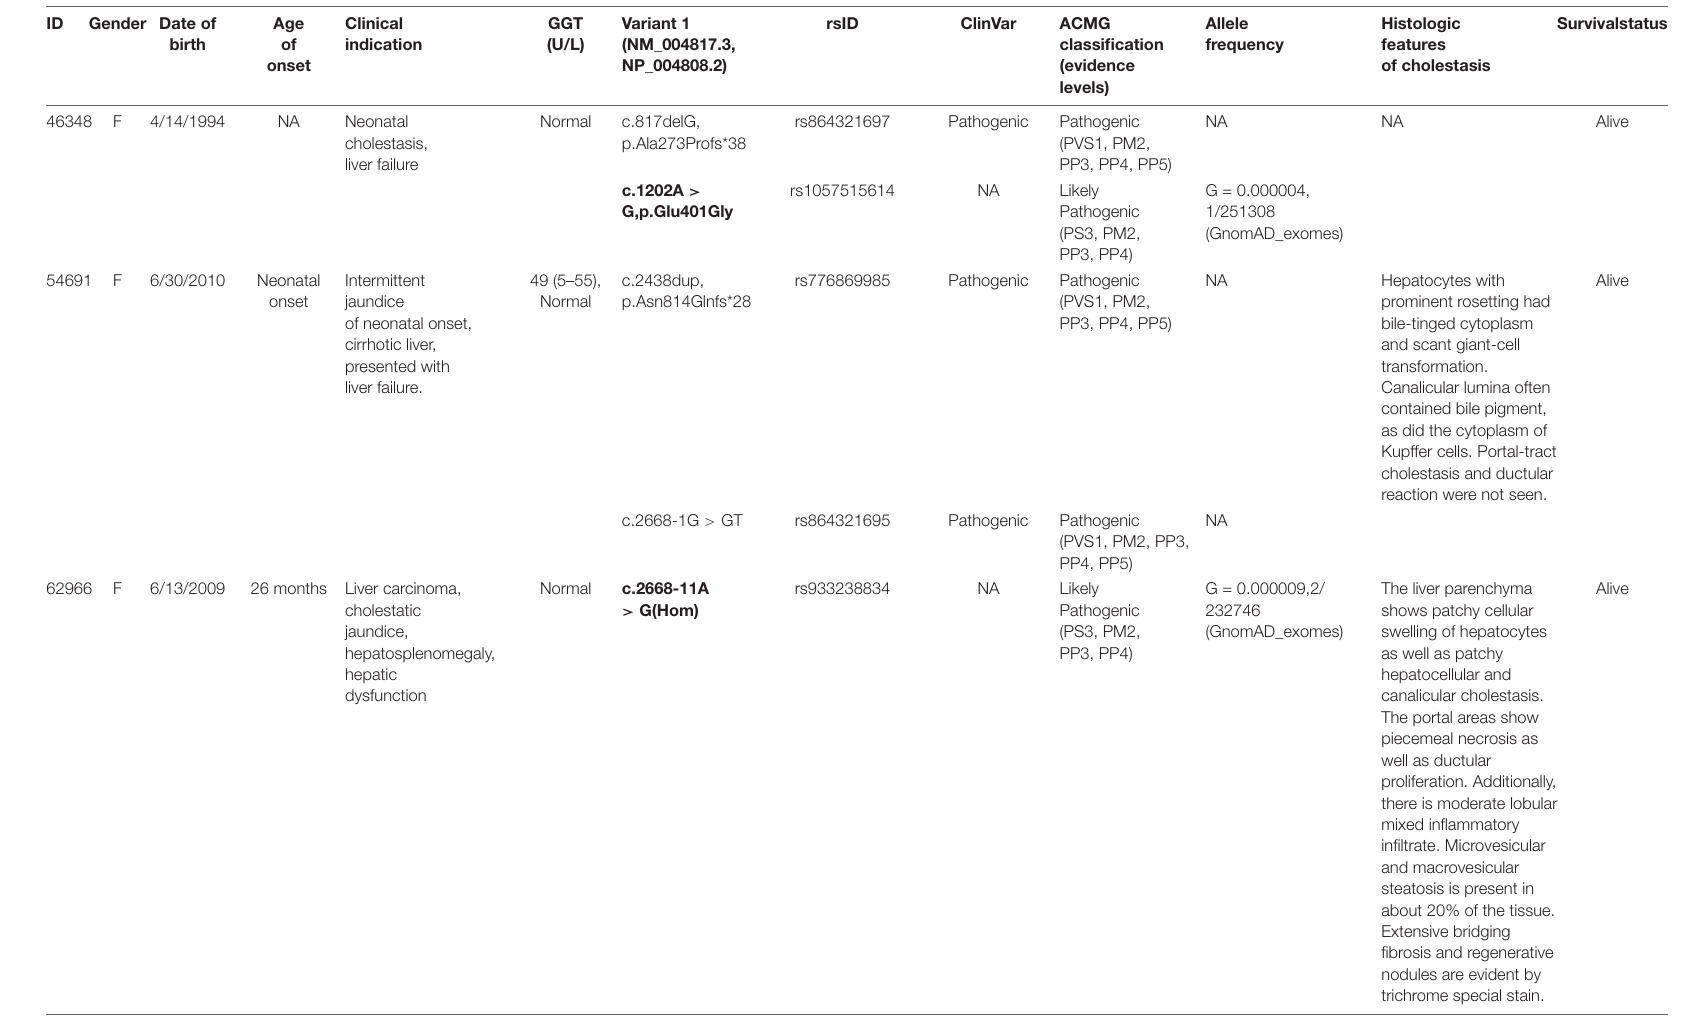
TABLE 1 | Five types of TJP2 gene variants detected in three